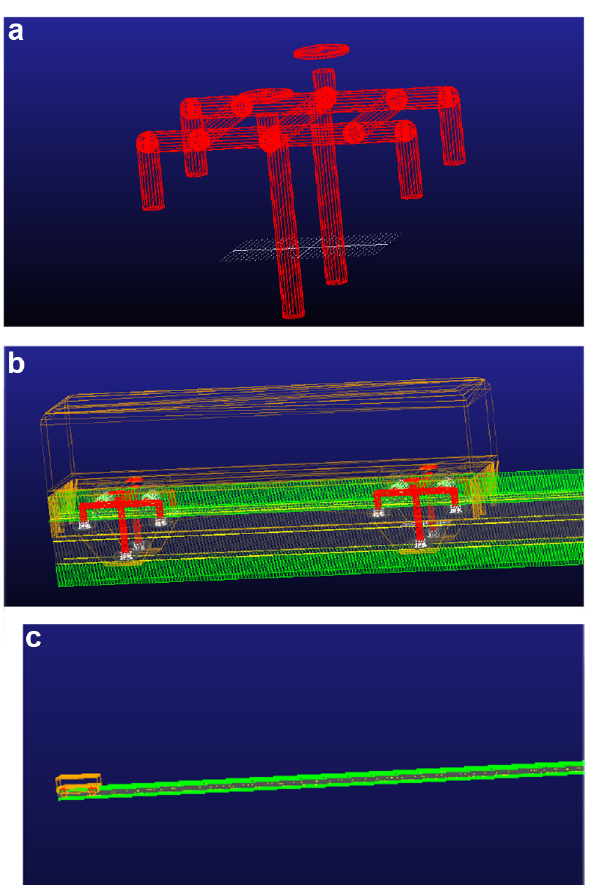
Fig. 3 Wheel–rail coupling dynamic model in Adams. a Bogie model, b vehicle model, c whole vehicle routing